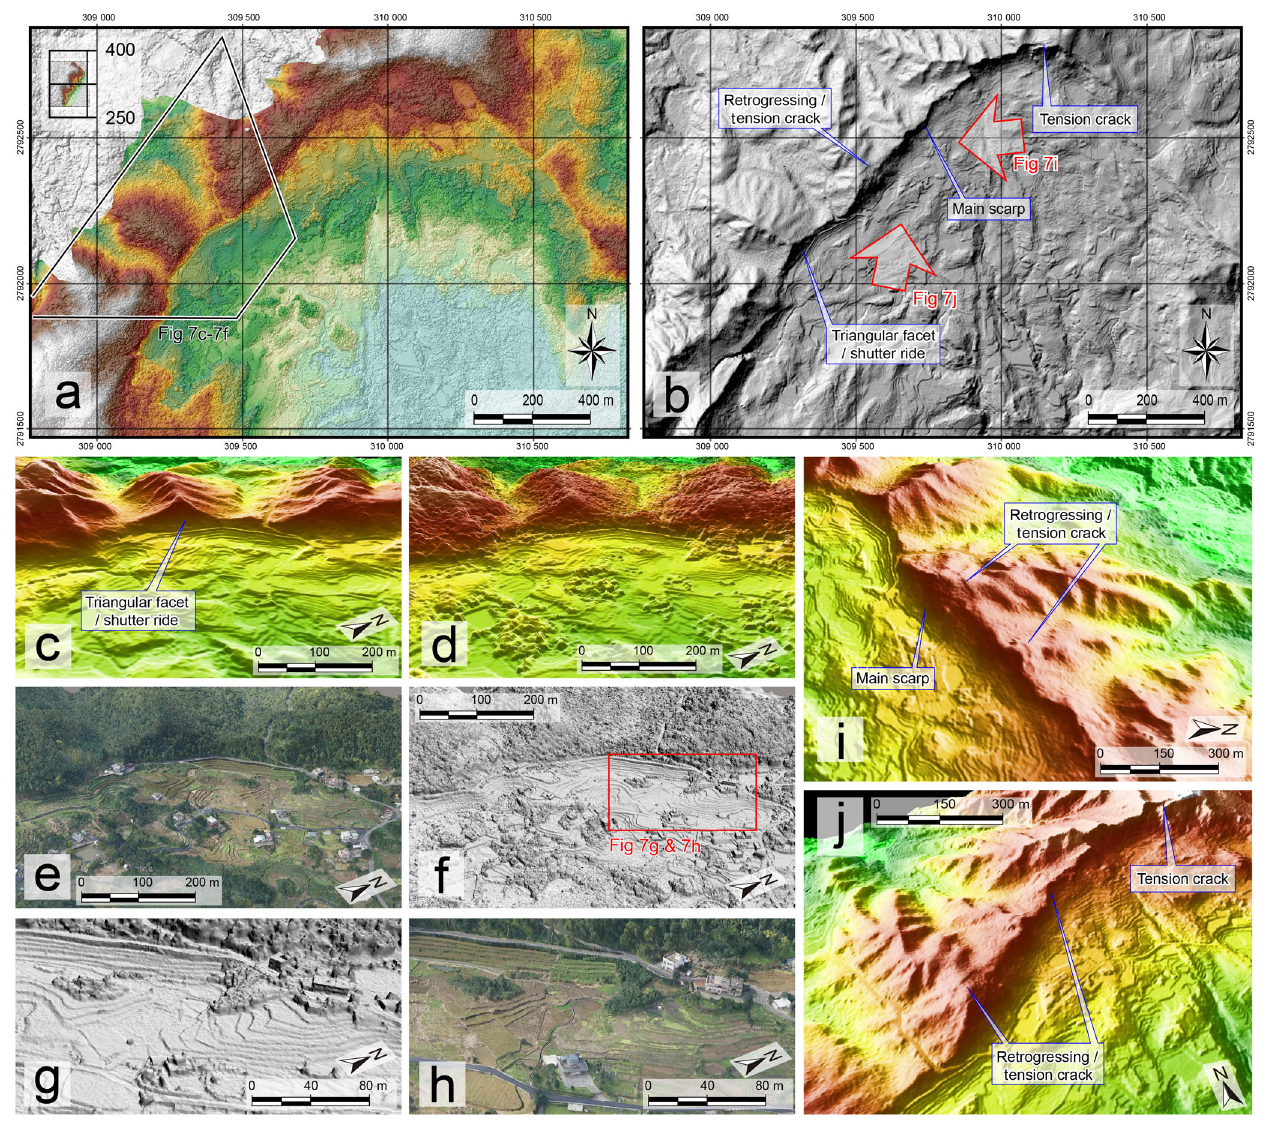
Figure 7. Comparison of topographic datasets for the same area acquired from different sources, including airborne lidar DSM, DTM, and UAS DSM. (a) UAS DSM data at 8.5cm resolution around the crown area of CSL; (b) hillshade image from 2m resolution lidar DTM, where (a) and (b) denote the same region and are indicated in Fig. 4; (c) magnified side view around the main scarp area from the lidar DTM; (d) magnified side view from lidar DSM; (e) UAS 3-D model magnified side view with optical images; (f) UAS 3-D model magnified hillshade side view, where (c) , (d) , (e) , and (f) share the same perspective, indicated in (a) ; (g, h) enlargement of the UAS 3-D model, indicated in (f) ; (i) color hillshade side view around main scarp; (j) another perspective view around main scarp. The direction of perspective view direction is indicated in (b) . Both (i) and (j) are illustrated from the lidar DTM. The morphological features, e.g., main scarp, shutter ridge, and triangular facet, are clearly observed. Note that retrogressive tension cracks were identified above the main